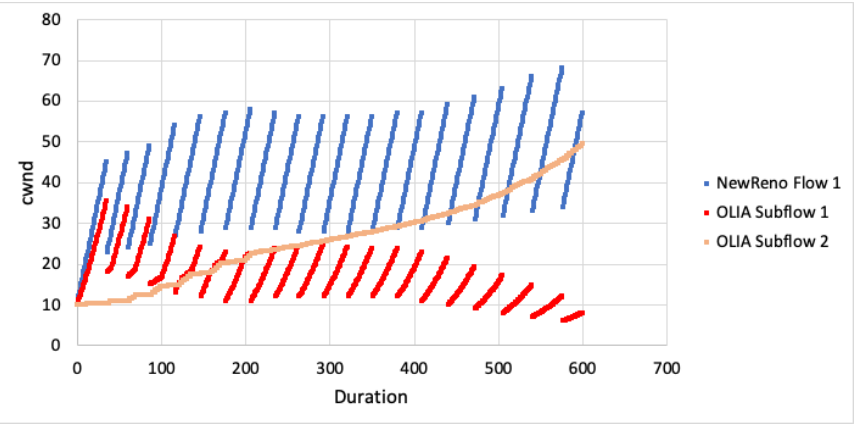
Figure 16. OLIA—Competing Window Growth— Subflow 1 RTT = x , Subflow 2 RTT = 3 x .